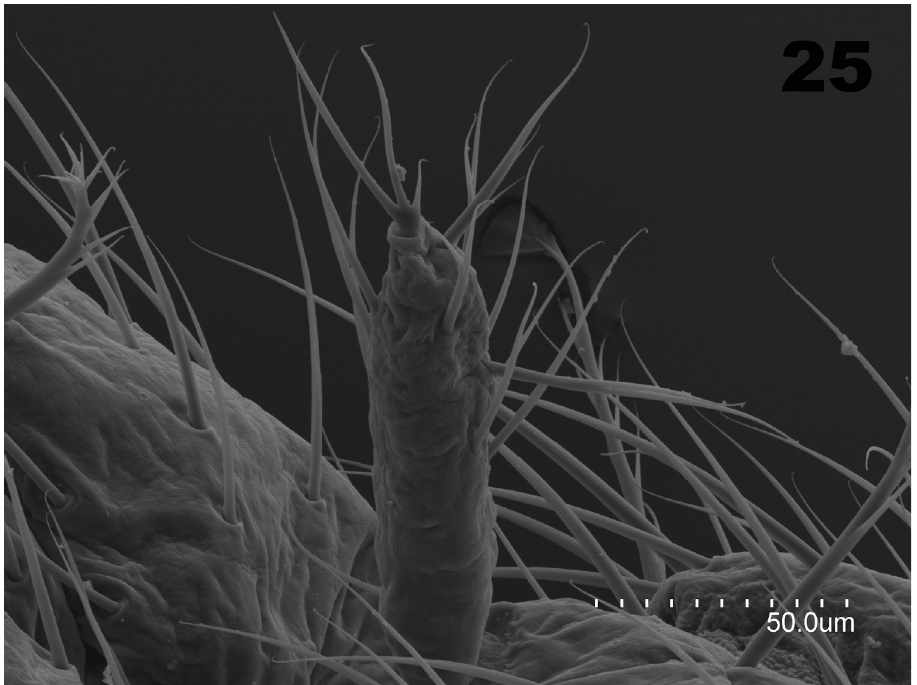
Figure 25. Haplocampa wagnelli Sendra, sp. n. Left stylus of the sixth